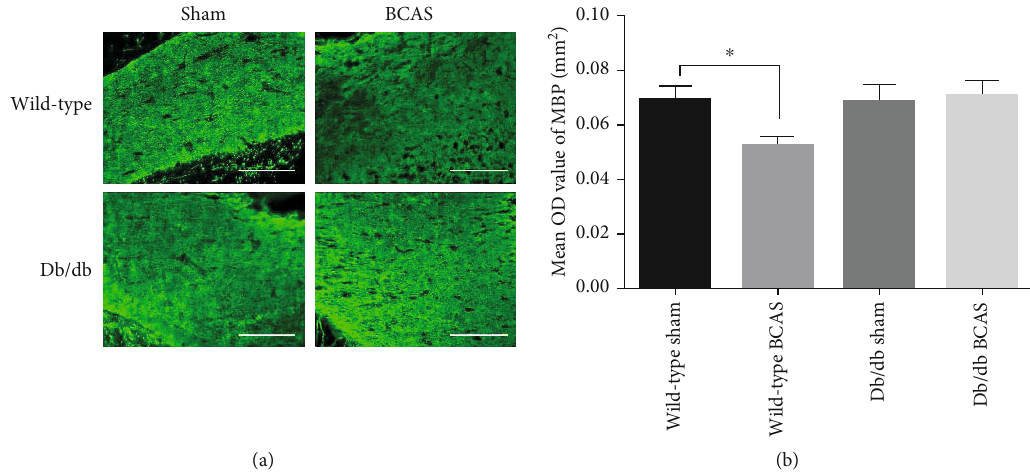
Figure 5: MBP expression in the corpus callosum of wild-type and db/db mice with sham or BCAS operation for four weeks. (a). Immuno fl uorescence staining of MBP. (b). Histogram showed the mean OD value of MBP in mice from di ff erent groups. N = 3 − 5 , scale bar = 100 μ m , and ∗ p < 0 : 05